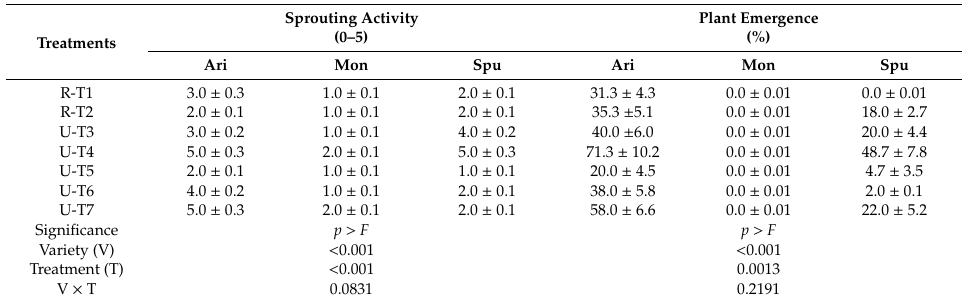
Table 11. In Experiment 2, average ( ± standard error) sprouting activity ranked with the use of a visual scale from 0 (full dormancy) to 5 (full sprouting), and average ( ± standard error) plant emergence (%) at the monitoring date of September 15 (24 days after planting).